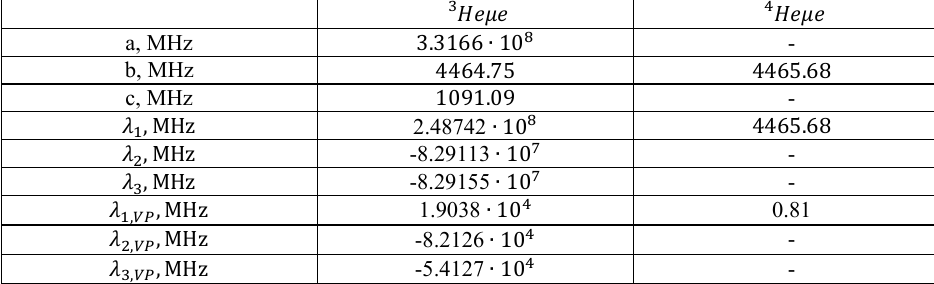
Table 3. Numerical values of hyperfine splitting with the correction to vacuum